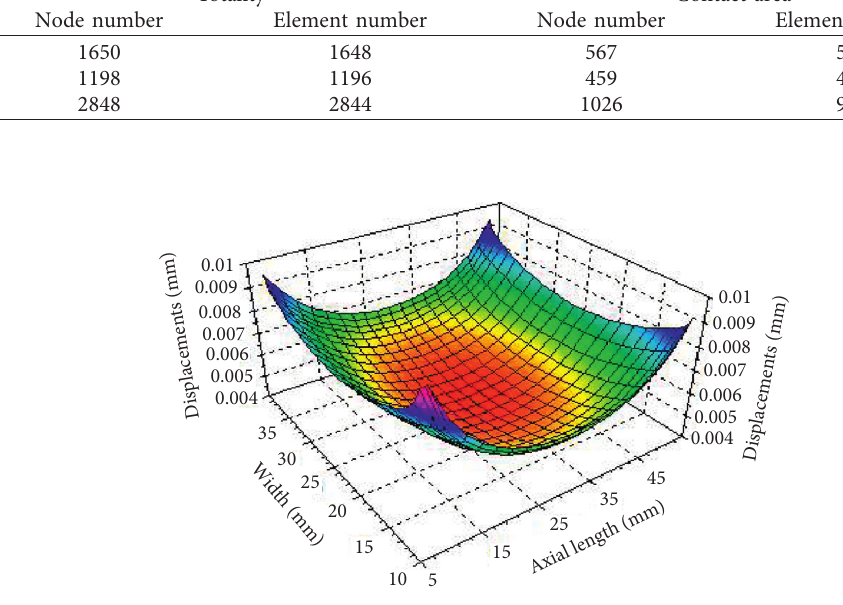
Figure 4: Displacement distributions in the contact